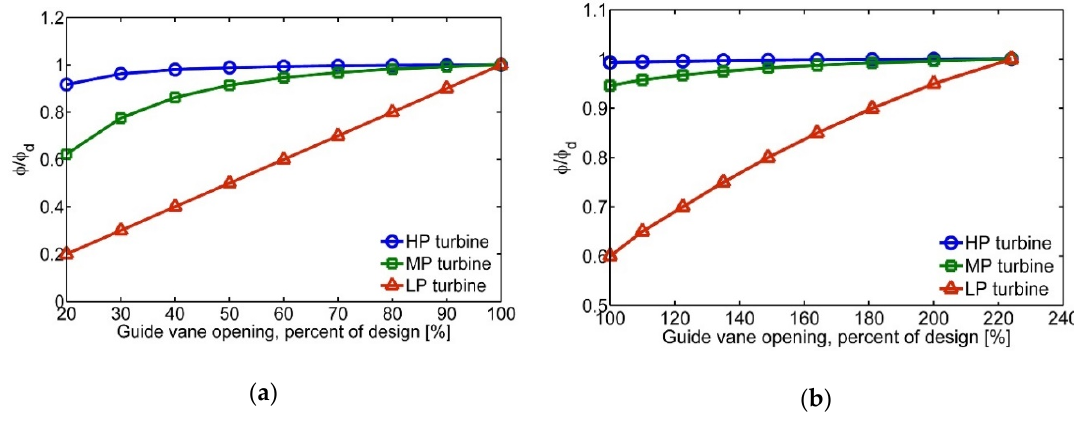
Figure 9. Flow coe ffi cient variation for the multistage turbine under guide vane opening change: ( a ) down-regulation at rated inlet pressure; ( b ) up-regulation at 60% of the rated inlet pressure.